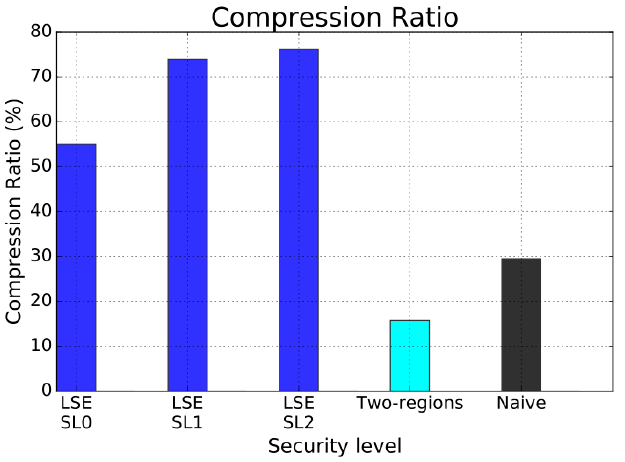
Figure 11. Compression ratio of the multi-region, two-region approach/compression, and Naïve approach/compression encryption approaches.